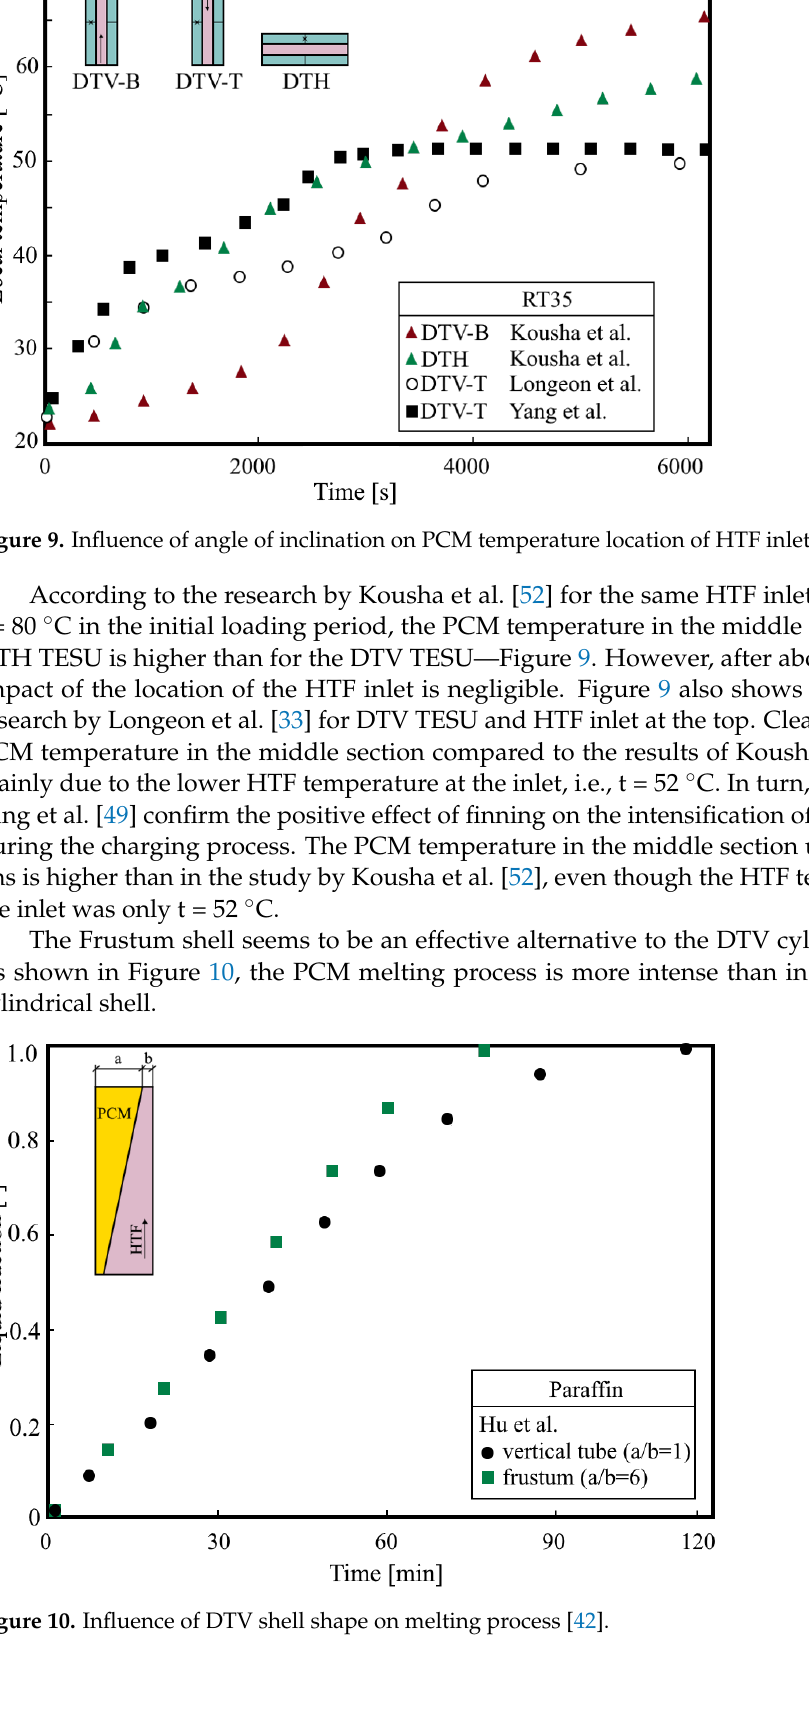
Figure 11. Comparison of PCM temperature for DTH and TTH [52,90]. Figure 12 shows the influence of the HTE technique on the melting process in TTH TESUs. The highest liquid fraction rate was obtained for Cu metallic foam and fins made of carbon fiber with a very high axial thermal conductivity — 900 W/(mK). The use of ex- ternal triangular fins — for the same HTF inlet temperature (90 °C) — gave significantly lower liquid fraction values. However, large-scale thermal energy storage will only be possible with MT TESUs. The work carried out so far concerns mostly systems with a very small number of tubes and a small amount of PCM. Test results obtained for small TESUs cannot be used in the design of large-scale systems. On the basis of the research carried out so far, it is difficult to clearly state which of the tube arrangement, namely in-line, staggered, or centrosym- metric, is the most advantageous from the point of view of TESU efficiency. The same applies to the pitch ratio and filling of the shell, defined as a ratio of the volume of the tube bundle to the shell volume.